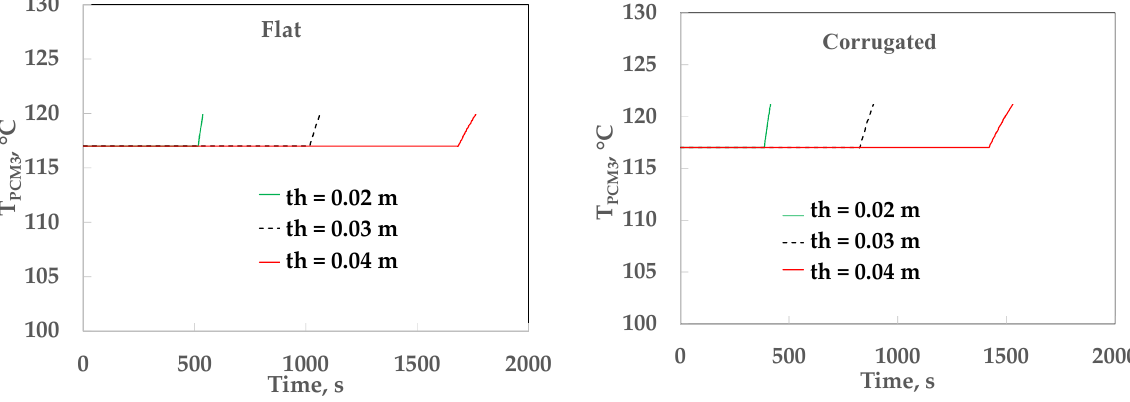
Figure 10. Temperatures profiles in the center of the PCM at different PCM thicknesses.